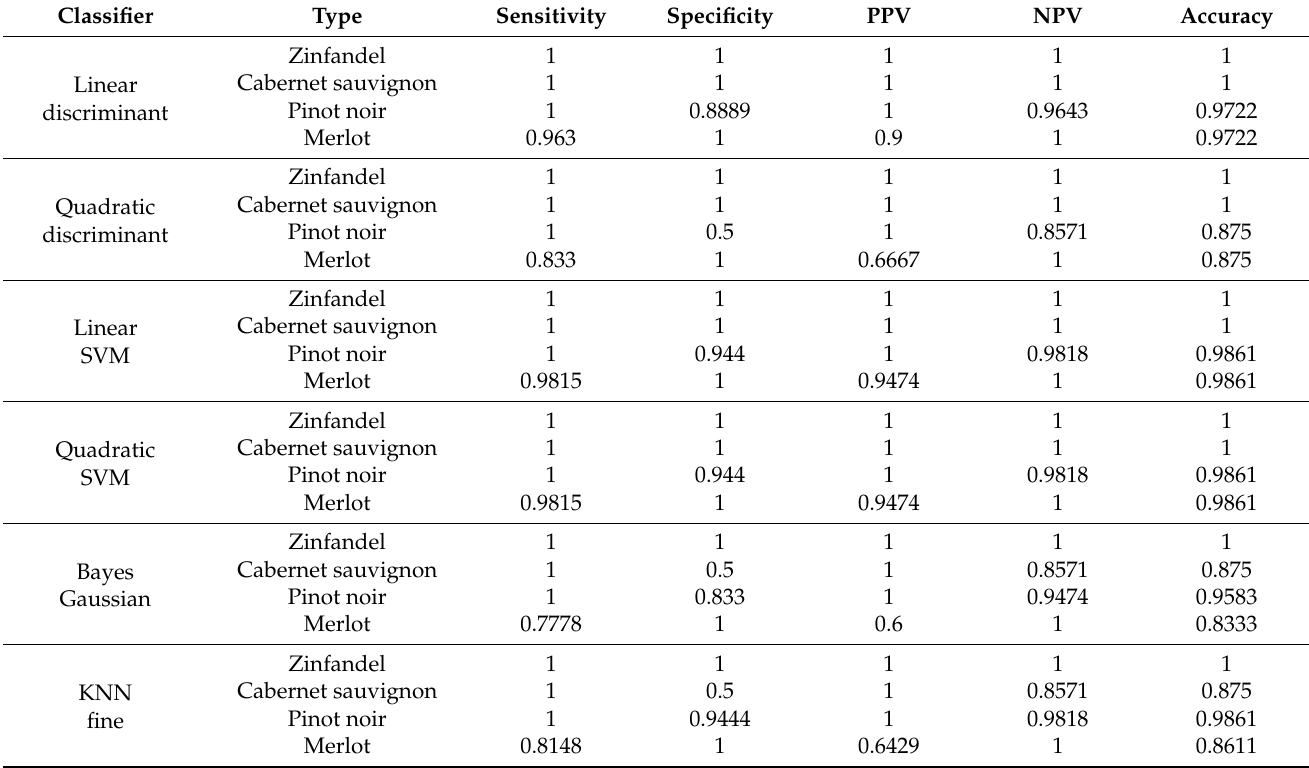
Table 1. Testing results from six different classifier models for wine samples.